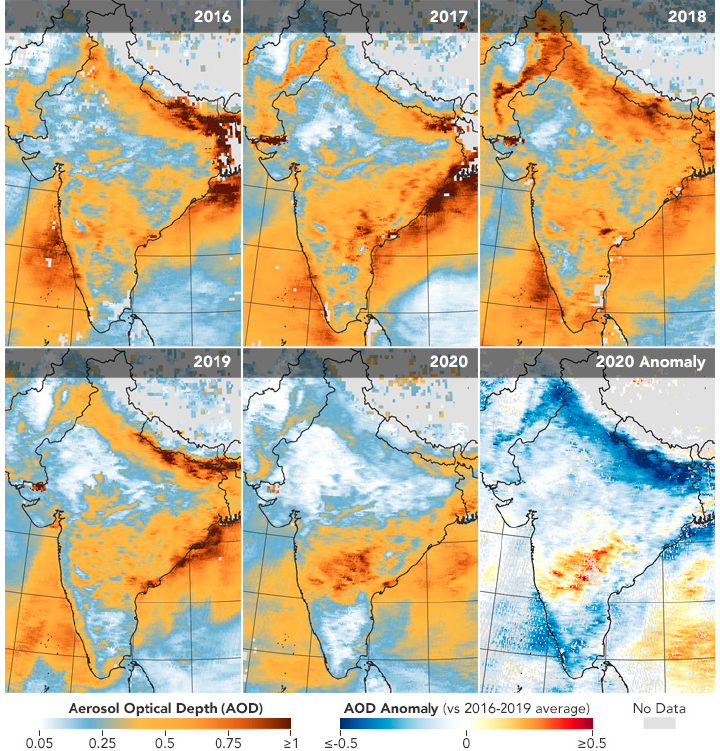
Figure 6. Aerosol optical depth (AOD) over India during March 31 to April 5 from 2016 through 2020. Source: https://earthobservatory.nasa.gov/images/146596/airborne-particle-levels-plummet-in-northern-india.